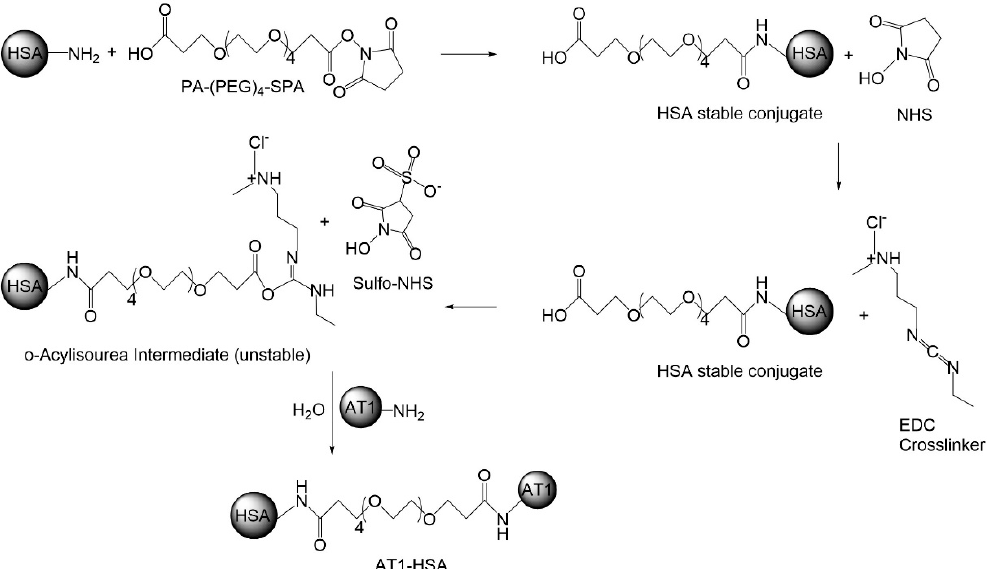
Figure 1. Schematic representation of the surface modification of the HSA molecule for binding with the AT1 peptide through a two-step chemical conjugation reaction using cross-linkers PA-(PEG) 4 -SPA and EDC/Sulfo-NHS.